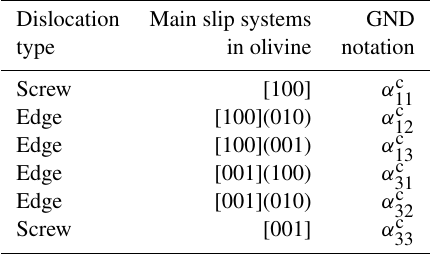
Table 3. Dislocation type, corresponding slip systems, and GND in the crystallographic frame ( α c ij